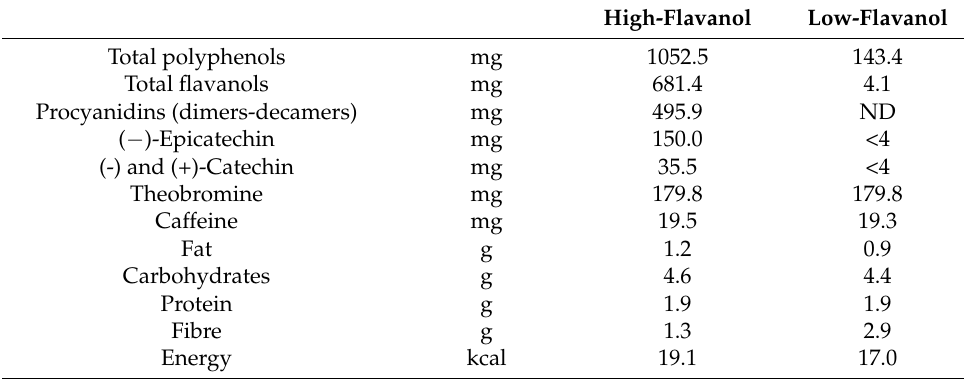
Table 1. Composition of cocoa interventions (8.3 g per individual dose) containing high and low flavanol content 1